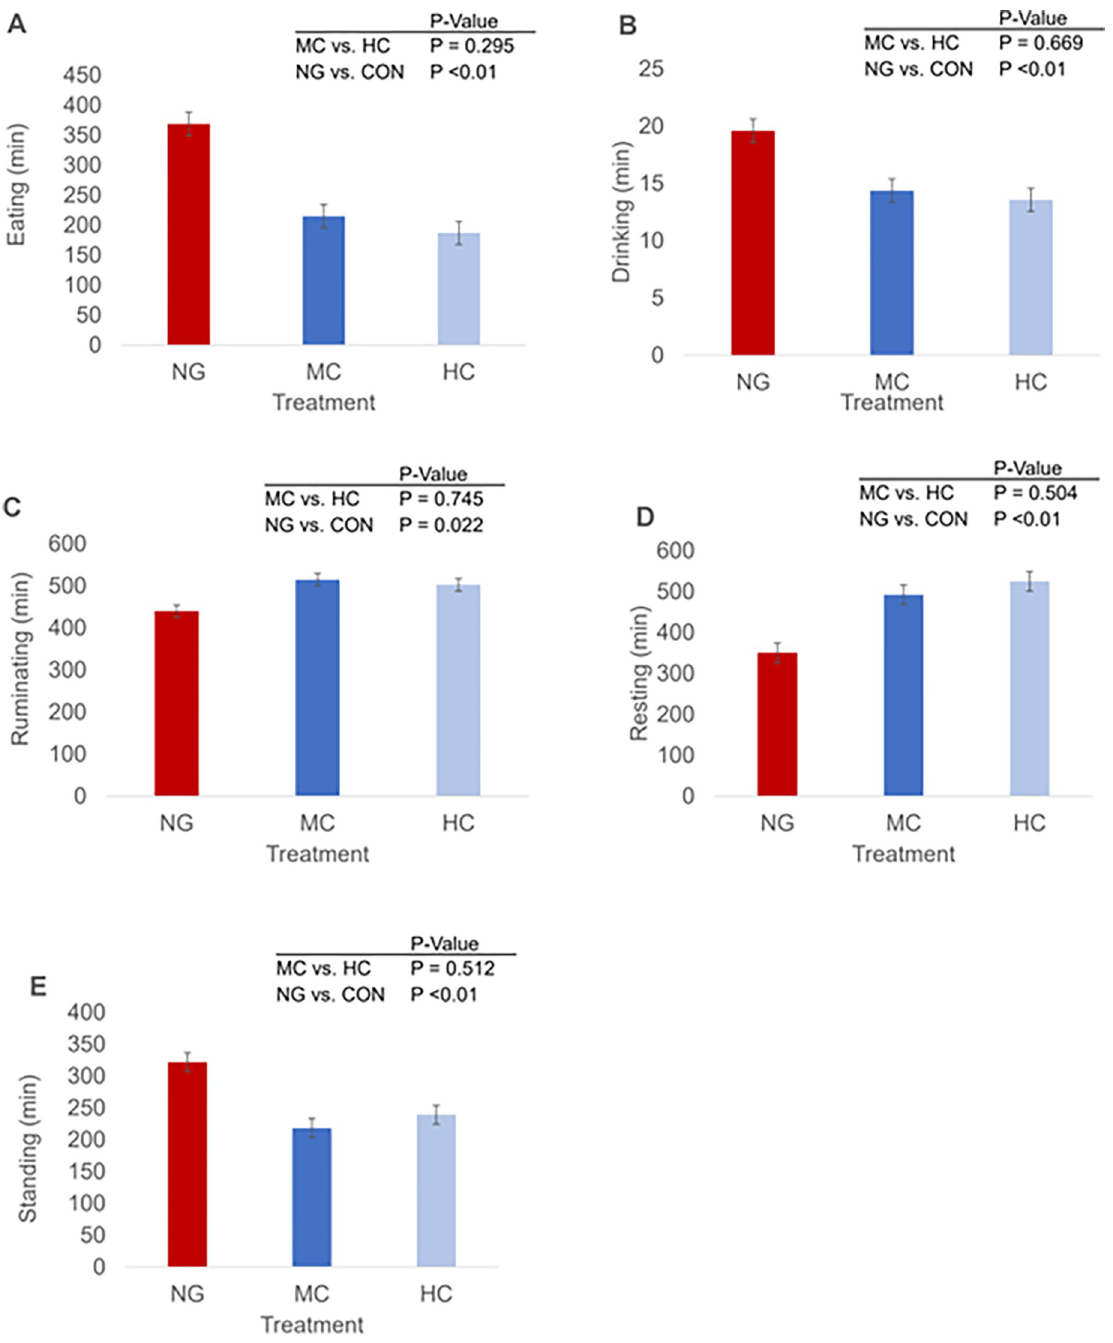
Fig 2. Lambs eating (A), drinking (B), ruminating (C), resting (D), and standing (E) behaviour by production system: NG = nomadic- grazing system, HC = high concentrate-based diet, MC = medium concentrate-based diet, CON = concentrate-based diet (including both HC and MC). Bars in each column represent the standard error of the